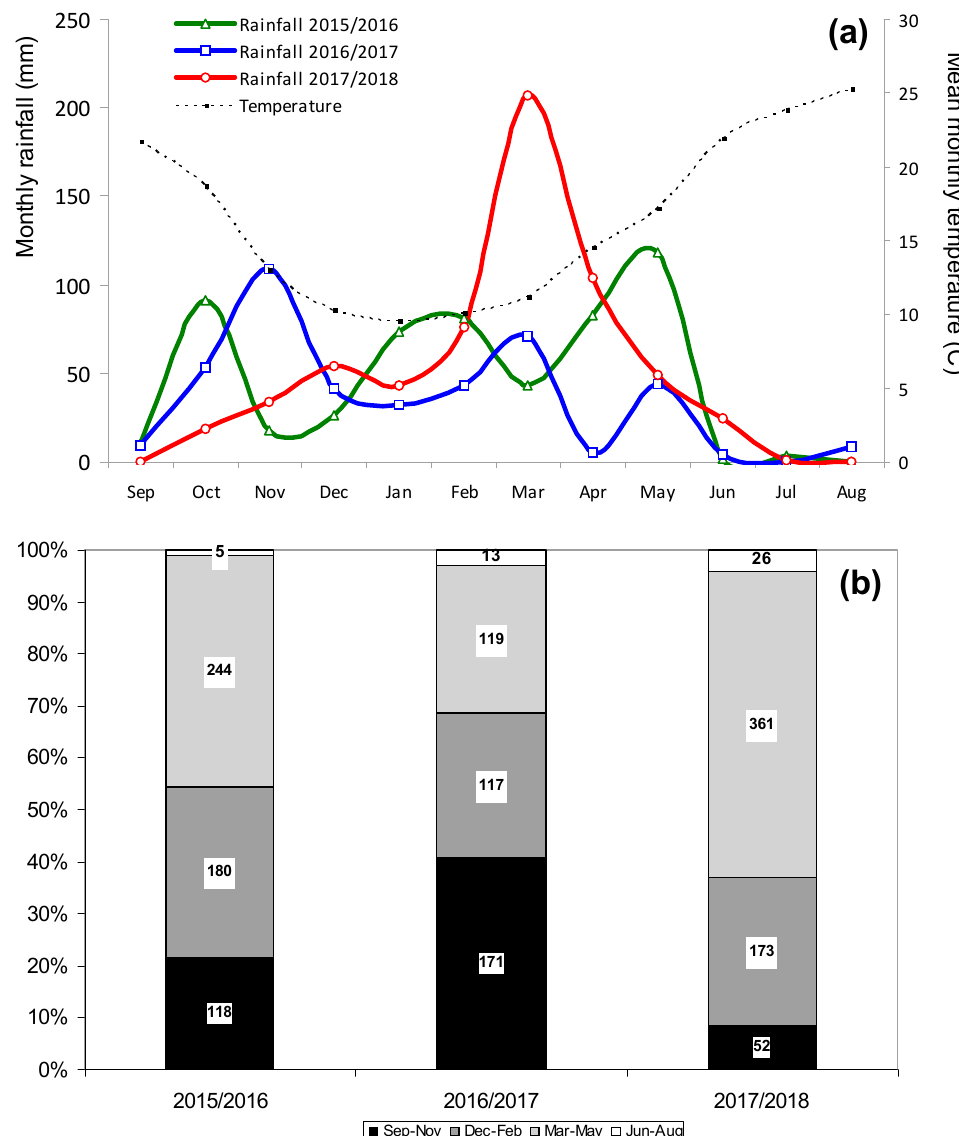
Figure 6. Monthly evolution of rainfall and mean temperature ( a ); and quarterly accumulated rainfall ( b ; in mm and %) over three years (2015–2016; 2016–2017 and 2017–2018) in “Mitra” experimental